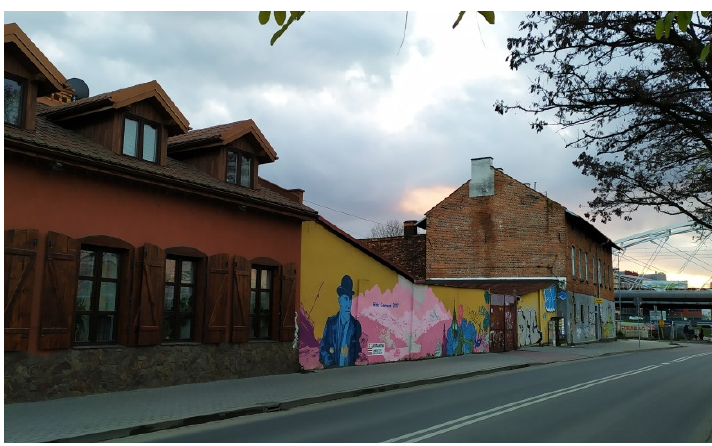
Figure 3. Objects recorded in the heritage register (photo by E. Latusek).